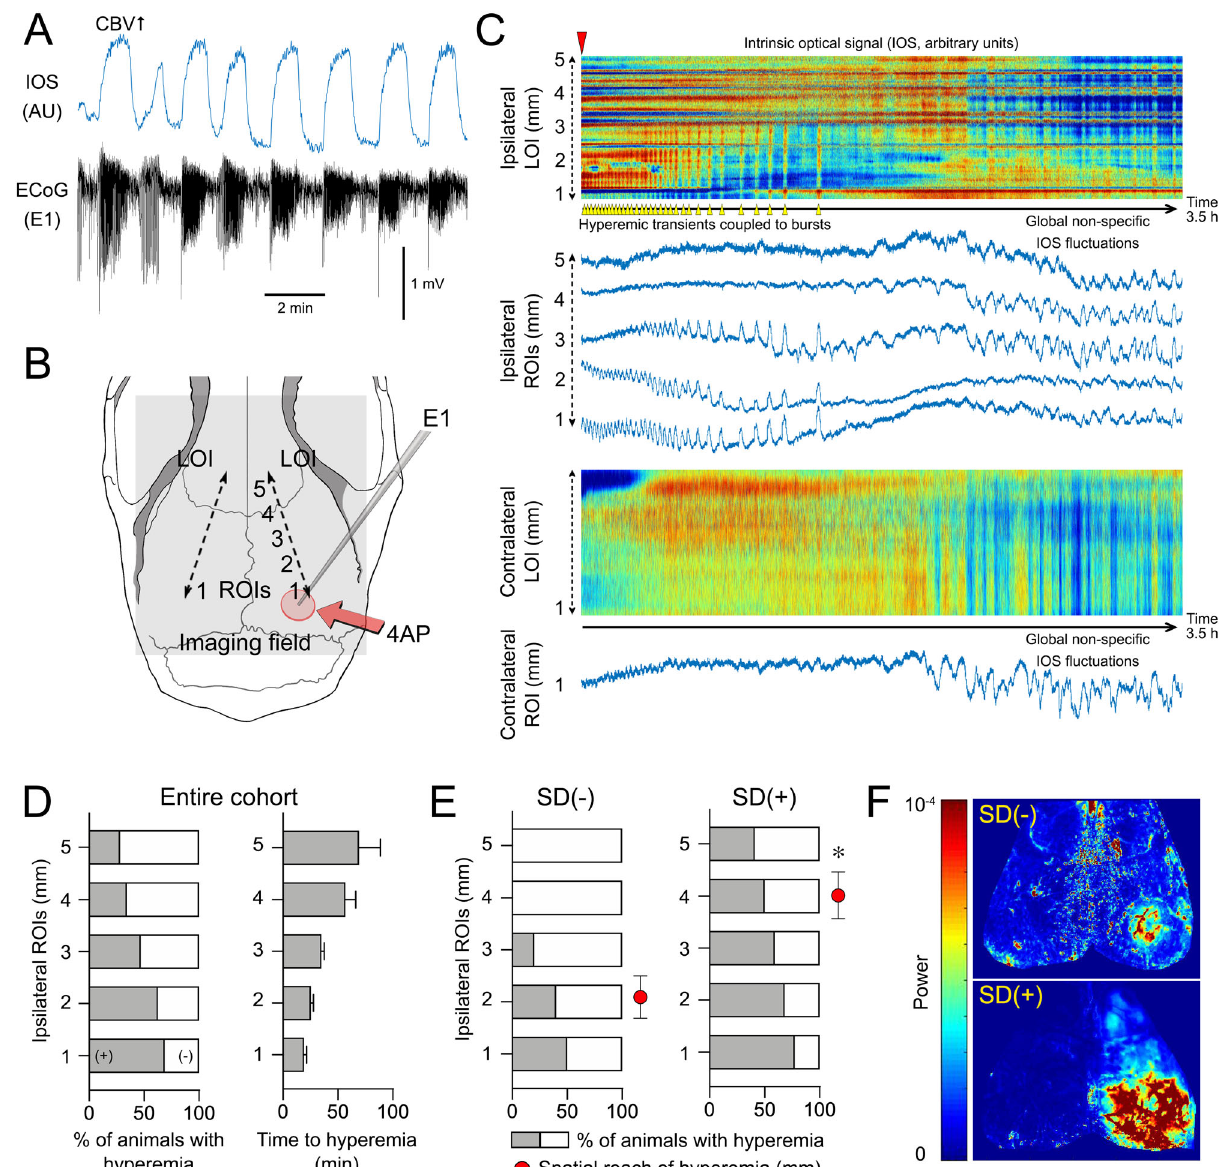
Fig. 4 Spatial reach of seizures across the cortex predicts SD occurrence. A Representative 4AP experiment shows hyperemia coupled to seizure bursts (AU, arbitrary unit) used as a surrogate to examine the spatial spread of the seizure. B We placed a line of interest (LOI) extending from the drug application site anteriorly on the ipsilateral hemisphere, and one symmetrically on the contralateral hemisphere (dashed lines). Five ROIs (1 – 5) were placed along with the ipsilateral LOI at 1 mm intervals and a contralateral ROI was placed symmetrically to ipsilateral ROI 1. C IOS intensity along with the two LOIs and in each ROI are plotted over time. Red indicates an increase and blue decreases in CBV. Hyperemic transients (yellow arrowheads) reached ROI 3 within 25 min after 4AP (red arrowhead) but did not extend to ROI 4 (experiment without SD). Contralateral LOI and ROI did not show hyperemic bursts, indicating a lack of generalization. Non-speci fi c CBV fl uctuations (e.g., due to blood pressure), were distinguishable by their global nature and time course. D The proportion of animals that developed hyperemic transients within each ROI and the time of their onset after 4AP application (±SEM). E Hyperemic transients showed a farther spread in animals that eventually developed an SD. Red circles indicate the average distance hyperemic transients reached from the drug application site in each subgroup (* p = 0.012, unpaired t -test; ±SEM). F Representative CBV power maps show a larger area of cortex with the hyperemic transients in the animal that eventually developed an SD (red high and blue low